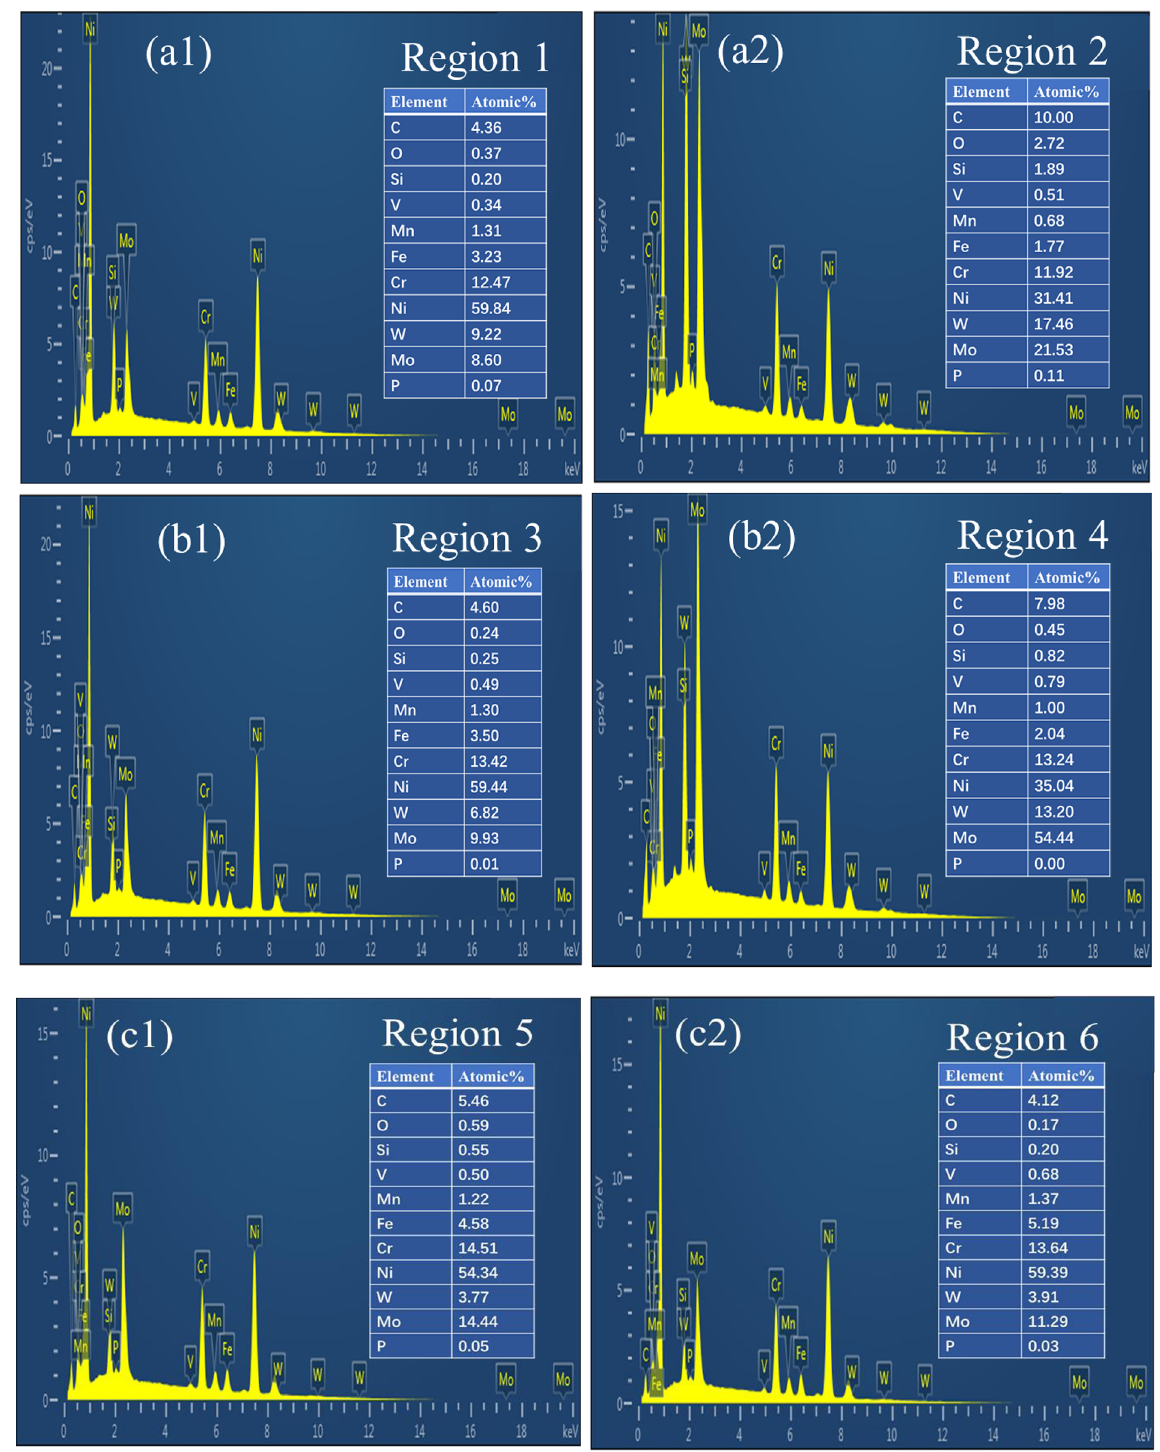
Figure 3: EDS results of di ff erent regions in Figure 2: ( a1 ) and ( a2 ) Ni + 30% WC; ( b1 ) and ( b2 ) Ni + 15% WC; ( c1 ) and ( c2 ) Ni